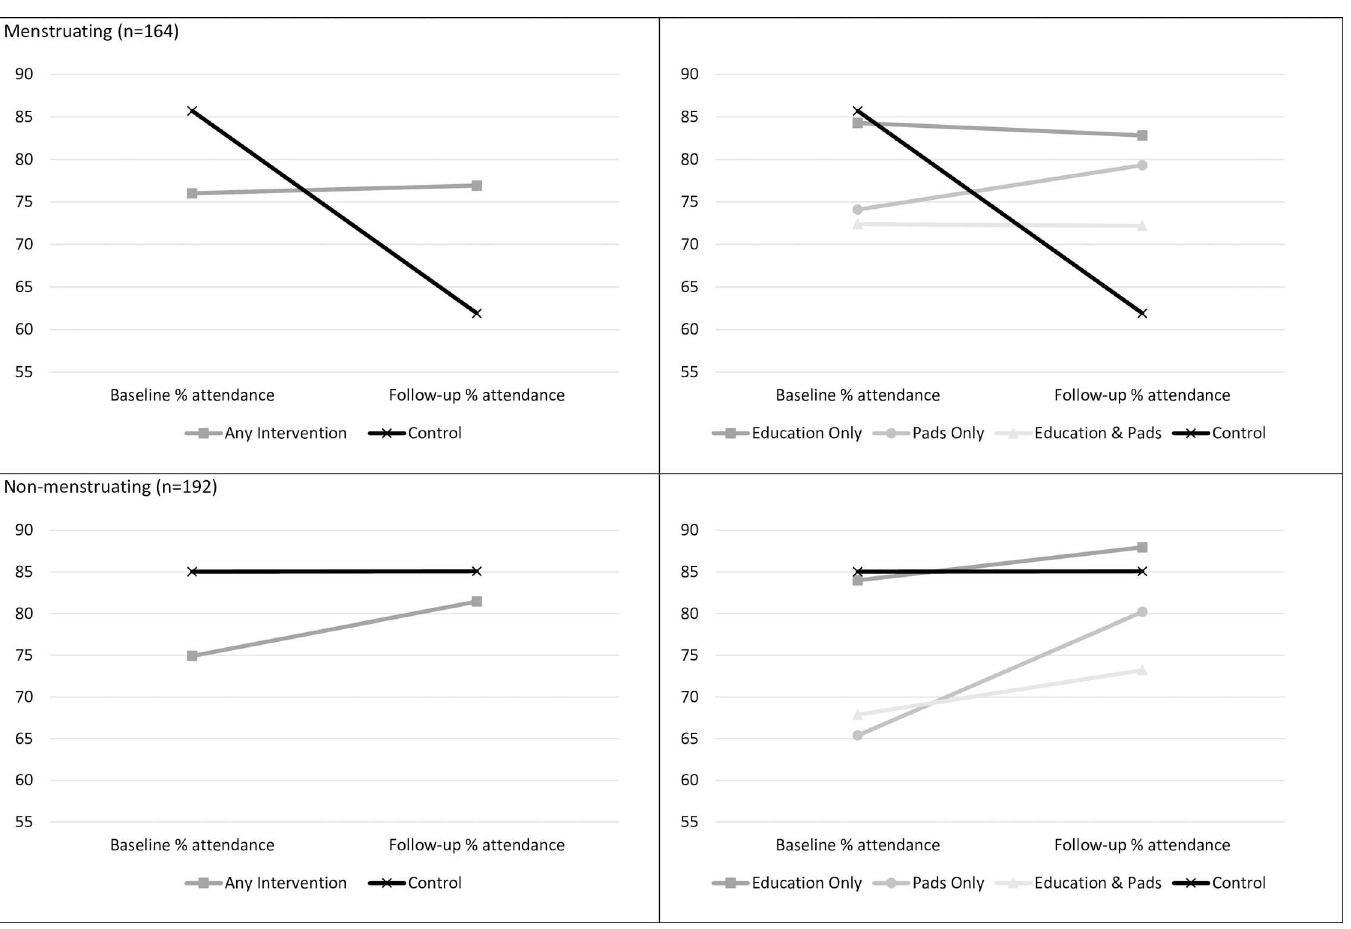
Fig 4. Mean baseline and follow-up percentage attendance according to girls’ menstrual status at study conclusion (n =